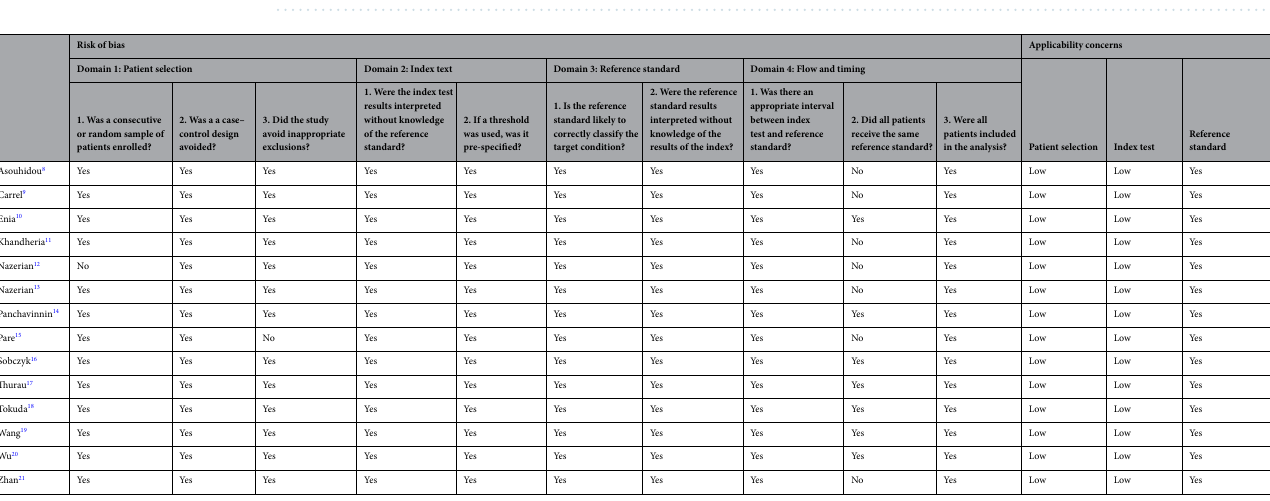
Table 1. Characteristics of included studies. Sing . single-center, Mult . multi-center, Pro . prospective, Retro . retrospective, CT computed tomography; CTA computed tomography angiography; MRI magnetic resonance imaging.